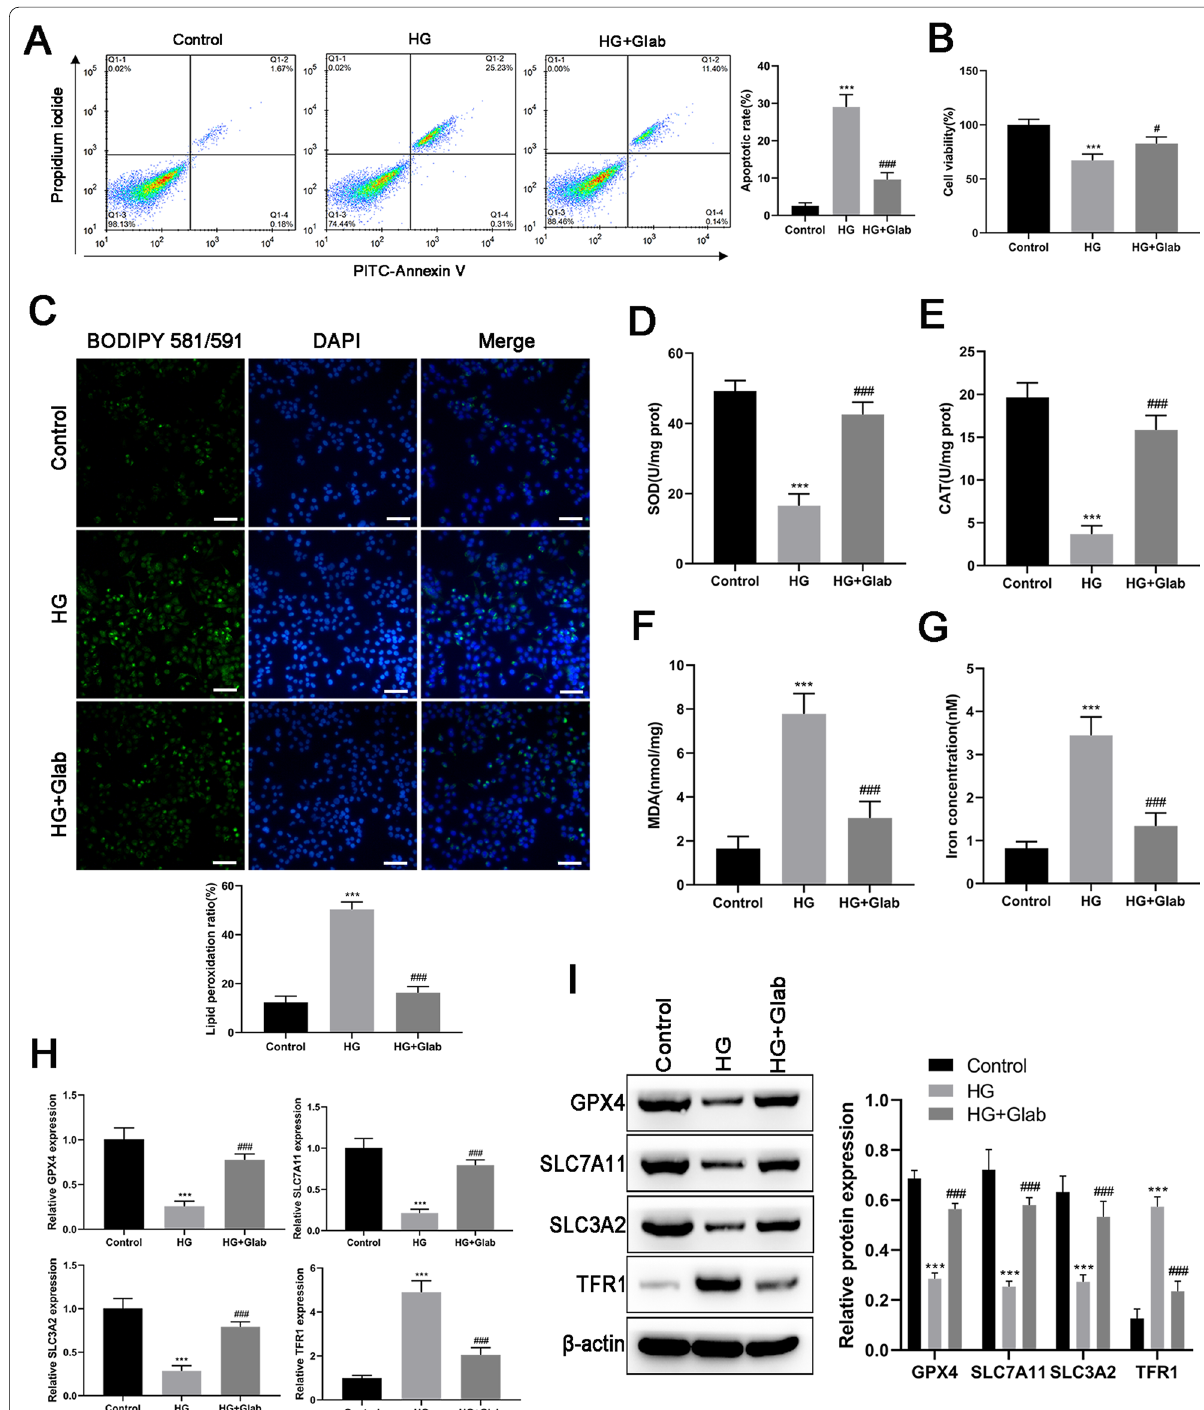
Fig. 6 Effects of Glab on high glucose (HG) induced oxidative stress and ferroptosis in vitro. The condition of DN in NRK-52E cells was induced by 30 mM glucose. A Cell apoptosis was detected by annexin V-PI double staining. B Cell viability detected by CCK-8 assay. C Lipid peroxidation was determined by the fluorescent probe C11 BODIPY 581/591. Green and blue colors indicate peroxidated lipids and nucleus respectively. The levels of ( D ) SOD, ( E ) CAT, ( F ) MDA, as well as ( G ) iron concentration were measured by commercial kits. The expression of ferroptosis markers (GPX4, SLC7A11, SLC3A2, and TFR1) at ( H ) mRNA and ( I ) protein levels were detected by RT-qPCR and western blot, respectively ( *** P < 0.005, vs. the control group; # P < 0.05 and ### P < 0.005, vs. the HG